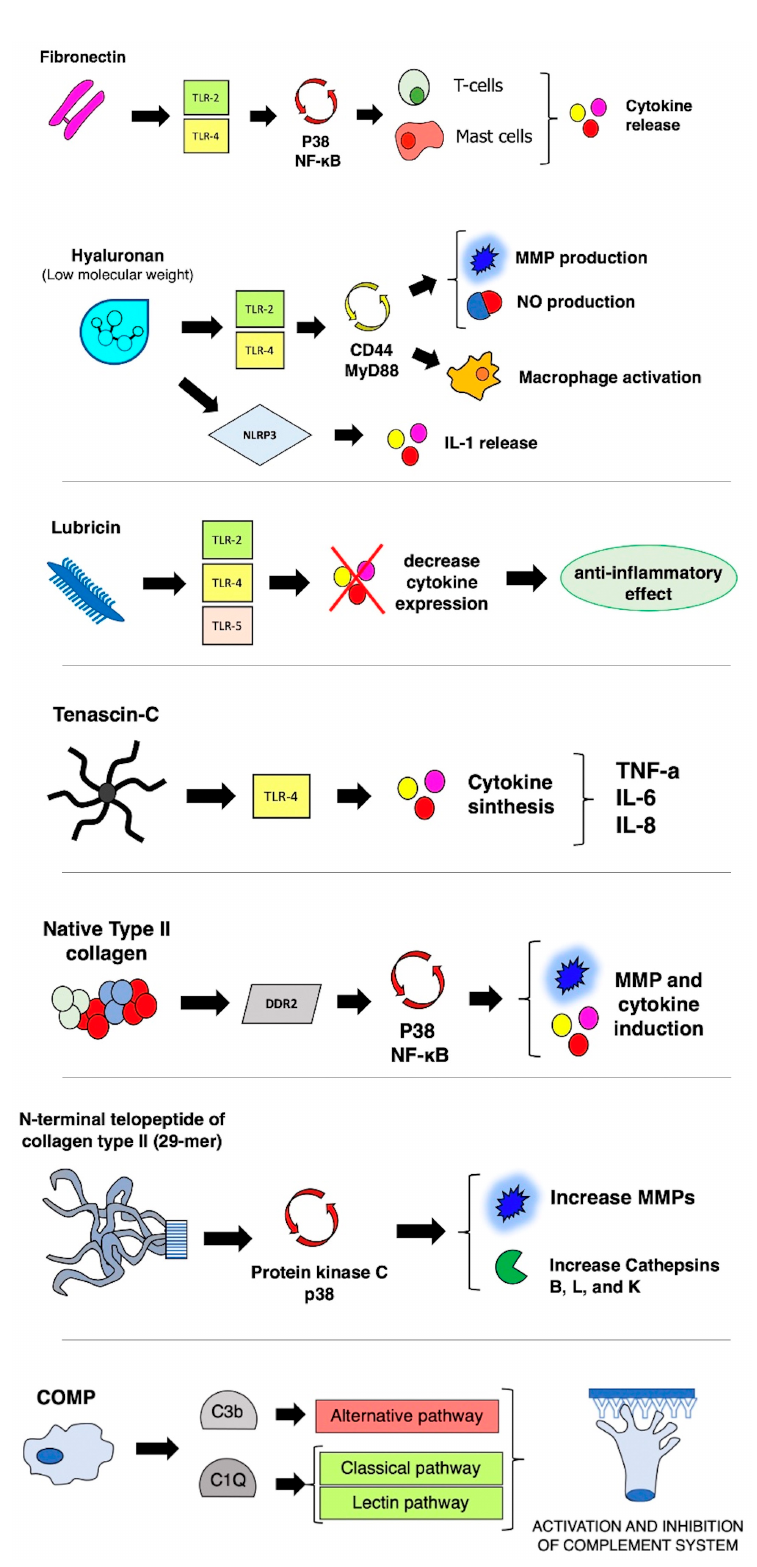
Figure 2. Schematic representation of inflammatory mechanisms mediated by different DAMPs. COMP: cartilage oligomeric matrix protein. Receptors: TLR: Toll-like receptor; NLRP3: NOD-like receptor family, pyrin domain containing 3; DDR2: Discoidin domain-containing receptor 2. Signaling pathway: p38: p38 mitogen-activated protein kinases; NF-kB: nuclear factor-kB; MyD88: myeloid differentiation primary response 88. Effects: MMP: matrix metalloproteinase; NO: nitric oxide; IL: interleukin; TNF: tumor necrosis factor.